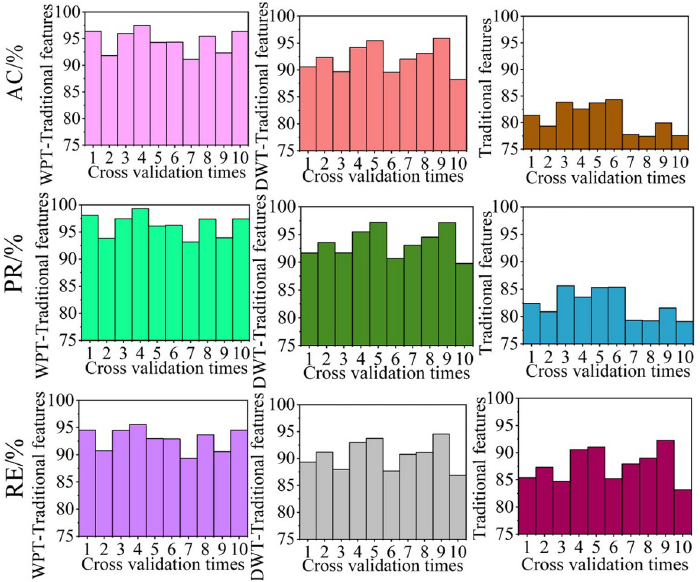
Fig 21. Performance comparison of disturbance recognition algorithms employing different feature extraction methods.